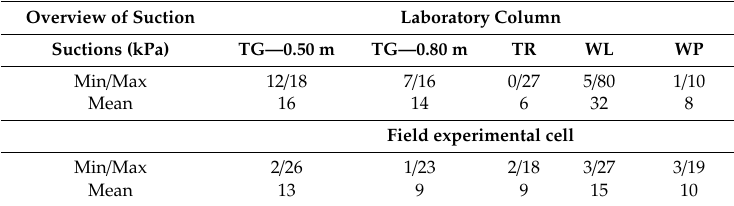
Table 3. Maximum, minimum, and mean suction values measured over the testing period.